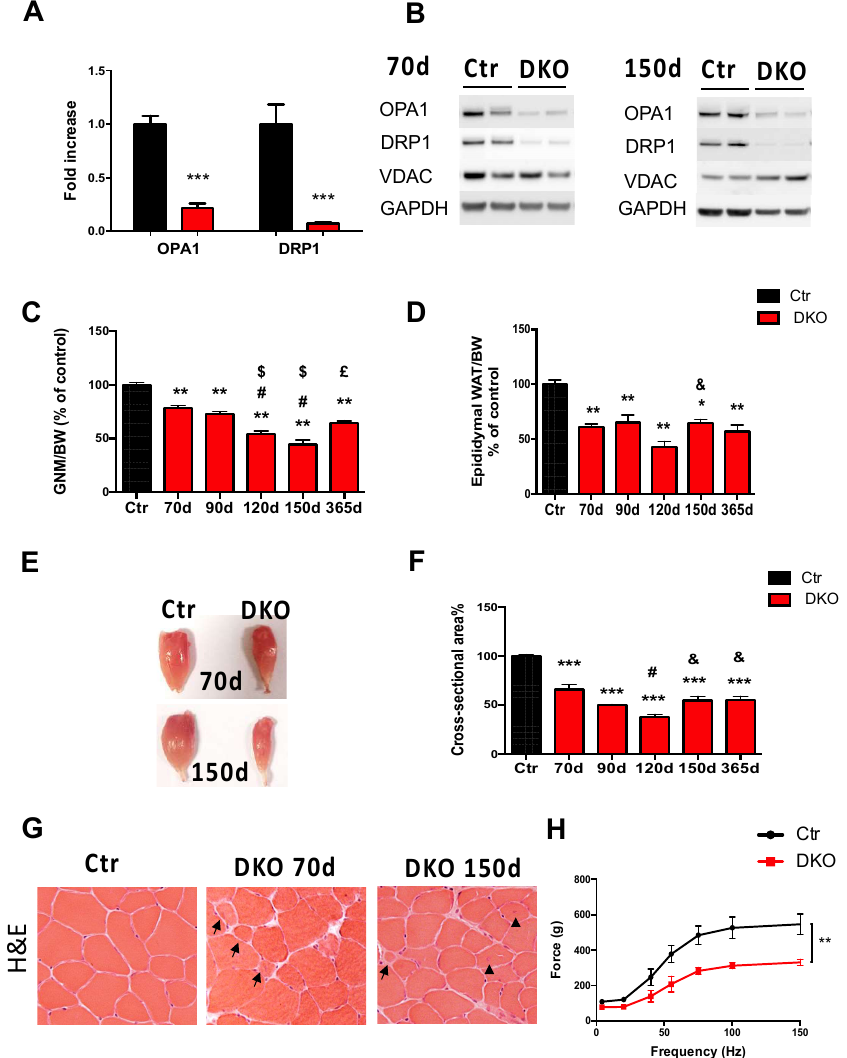
Figure 1. Losses of Opa1 and Drp1 in adult mice cause body weight (BW) loss, muscle atrophy, and muscle weakness. Opa1 and Drp1 mRNA ( A ) and protein levels ( B ) were decreased in DKO gastrocnemius (GNM) muscles. ( C ) Wet weight of GNM muscle normalized to BW and relative to control. ( D ) Epididymal fat content normalized to BW was decreased in DKO mice. ( E ) Dissected GNM muscles from control and DKO mice showed an important amount of atrophy after 70 and 150 days from tamoxifen treatment. ( F ) The quantification of cross-sectional areas within GNM individual myofibers confirms muscle atrophy in DKO mice. ( G ) Representative Hematoxylin & Eosin (H&E) staining of GNM. The arrows indicate very small fibers in both images “DKO 70d” and “DKO 150d”. Arrowheads in the image “DKO 150d” show the central nuclei. ( H ) Force measurements performed in vivo on GNM muscles. Absence of Opa1 and Drp1 leads to a significant decrease in absolute force. Data are shown as means ± SEM. Two-tailed unpaired Student’s t-test and 2-way analysis of variant (ANOVA) were used. Statistical significance: * p < 0.05, ** p < 0.01**, *** p < 0.001, compared to control; # compared to DKO 70d; $ compared to DKO 90d; & compared to DKO 120d; and £ versus DKO 150 days; 70 days, 90 days, 120 days, 150 days, and 365 days refer to days from the beginning of tamoxifen